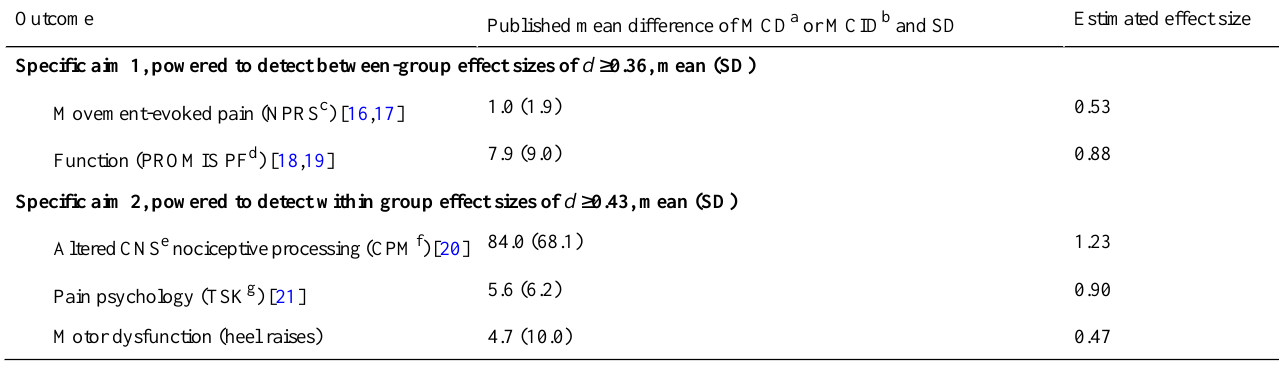
Table 1. The primary outcome measures are movement-evoked pain during single limb heel raises and self-reported function on the patient-reported outcome measure information system computer adaptive testing for Physical Function 2.0. Secondary outcomes include conditioned pain modulation as an indicator of altered central nervous system nociceptive processing, Tampa Scale of Kinesiophobia as an indicator of pain-related psychology, and maximum number of single limb heel raises as an indicator of motor